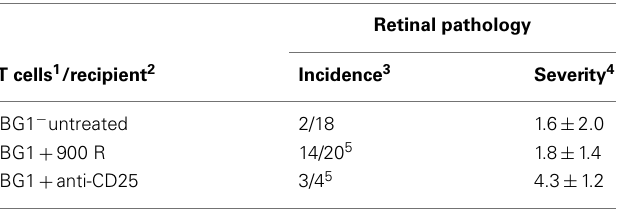
Table 1 | Induction of EAU by adoptive transfer of activated BG1T cells was enhanced by lymphopenia orTreg depletion.